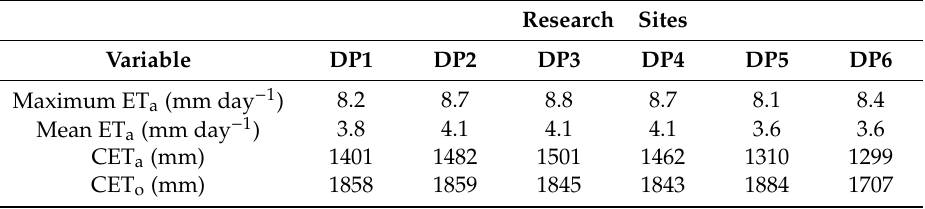
Table 5. Maximum and mean daily actual evapotranspiration (ET a ), cumulative actual evapotranspiration (CET a ), and cumulative reference evapotranspiration (CET o ) at the experimental sites over the 12-month study period (May 2019—April